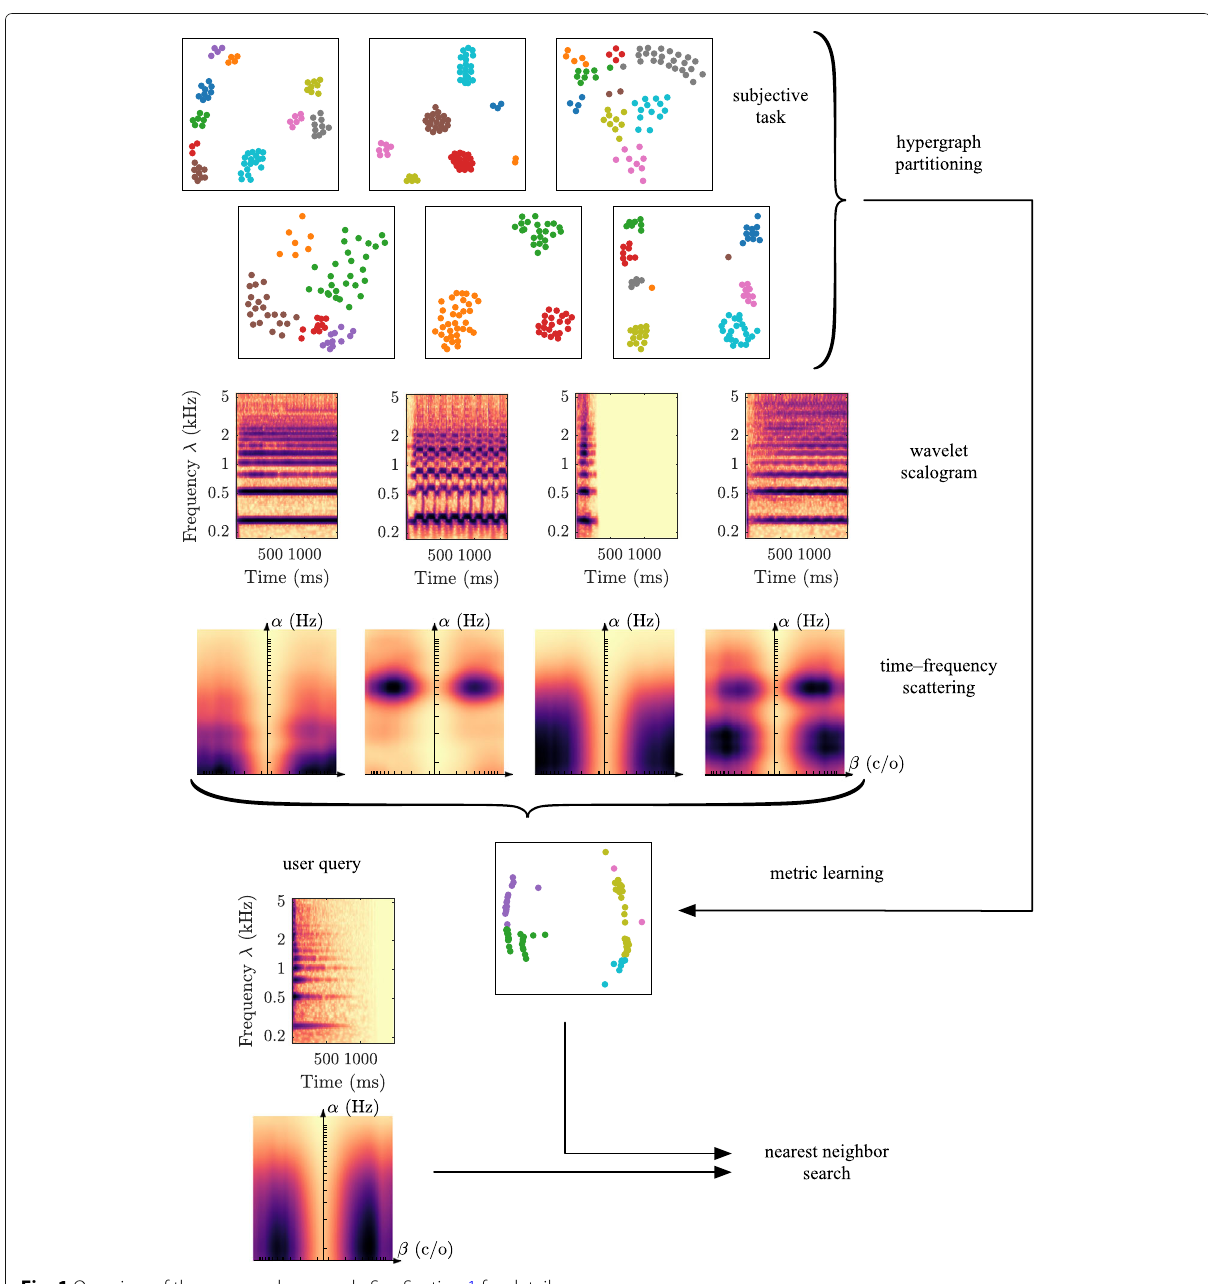
Fig. 1 Overview of the proposed approach. See Section 1 for details